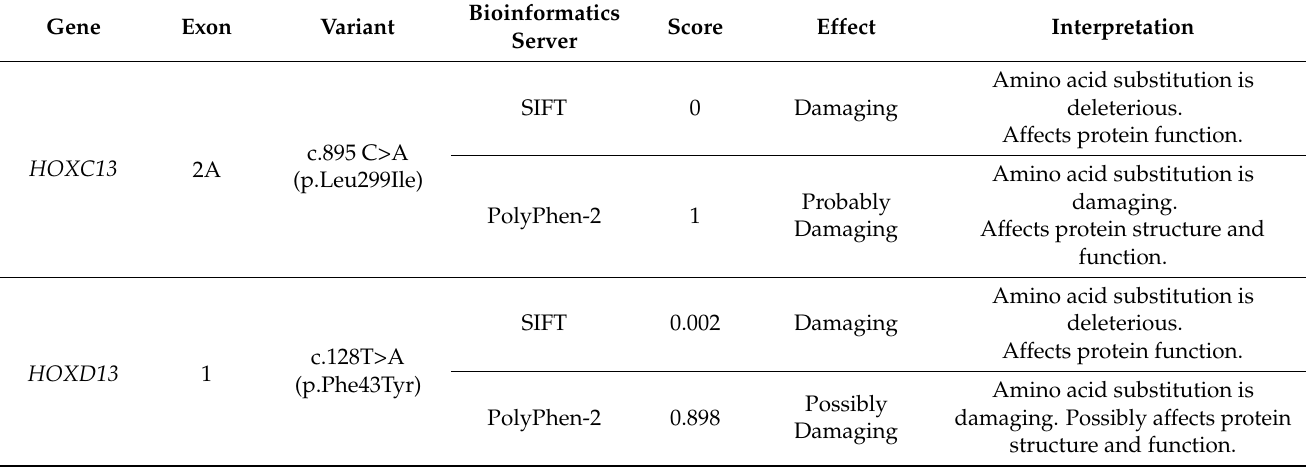
Figure 1. HOXC13 and HOXD13 gene variants identified in CC patients. Electropherograms showing the non-synonymous transversion, c.895C>A p.(Leu299Ile), and the synonymous transition, c.777C>T p.(Arg259Arg), both in a heterozygous state ( a , b , respectively), as well as the non-synonymous transversion, c.128T>A p.(Phe43Tyr), and the synonymous transitions, c.204G>A p.(Ala68Ala) and c.267G>A p.(Ser89Ser), all of which were observed in a heterozygous state ( c – e , respectively). Table 3. Bioinformatic analysis of coding variants in HOXC13 and HOXD13 Table 2. Allelic and genotypic frequencies of HOXC13 and HOXD13 gene variants.